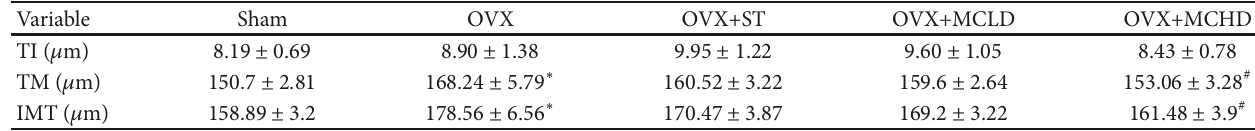
Table 2: Evaluation of aortic histomorphometry following MC